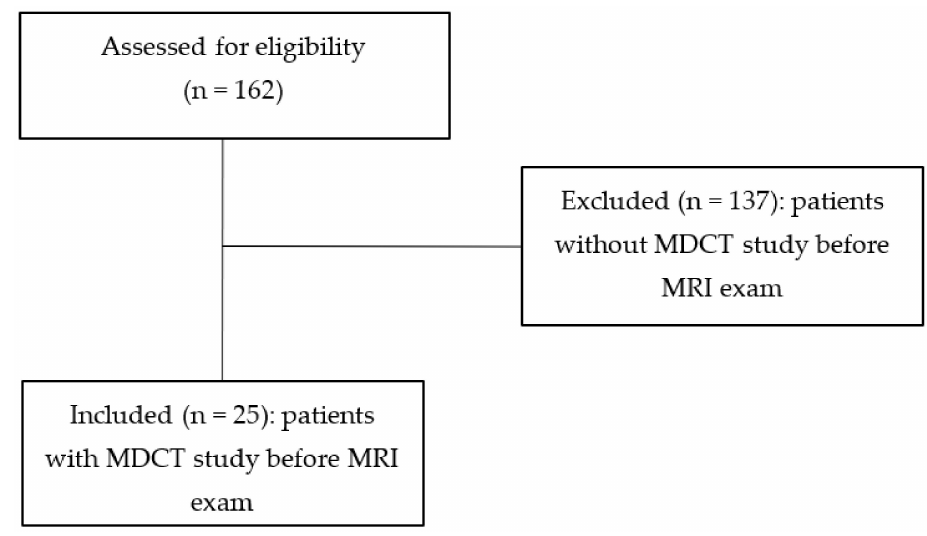
Figure 1. CONSORT flow diagram of selection of patients under study. In Table 1, the demographic data of the 25 included patients (medium age: 64.72; M/F = 15/10) are reported. Table 1. Demographic data of the subjects included in the